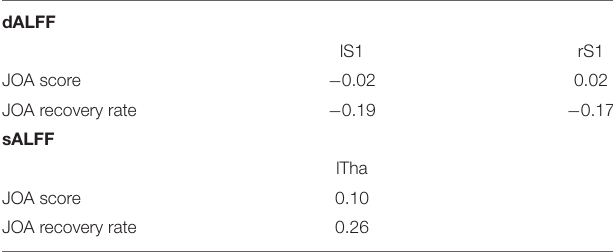
TABLE 3 | The correlation coefficients between altered brain function and clinical measures.